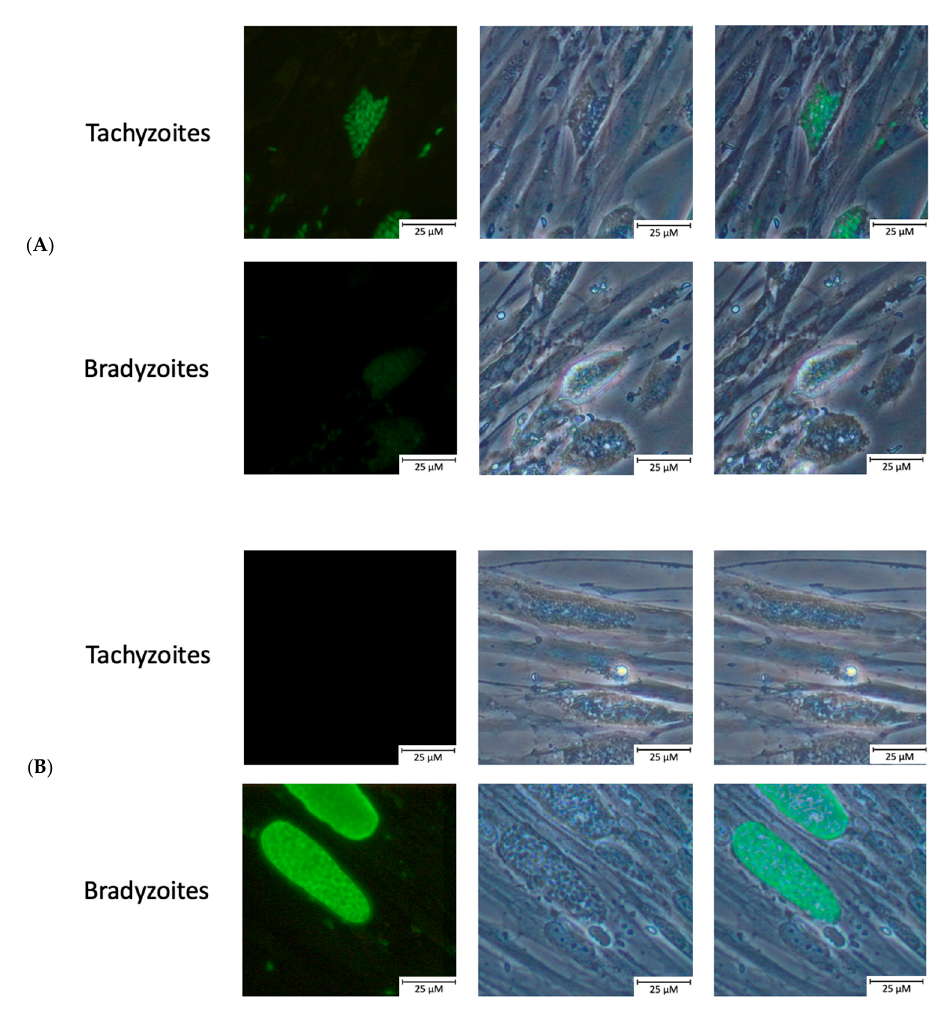
Figure 1. Confirmation of the differentiation of tachyzoites to bradyzoites by an immunofluorescent assay. ( A ) SAG1 tachyzoite-specific marker expression in Toxoplasma gondii ME49 strain. ( B ) MAG1 bradyzoite-specific marker expression in Toxoplasma gondii ME49 strain.